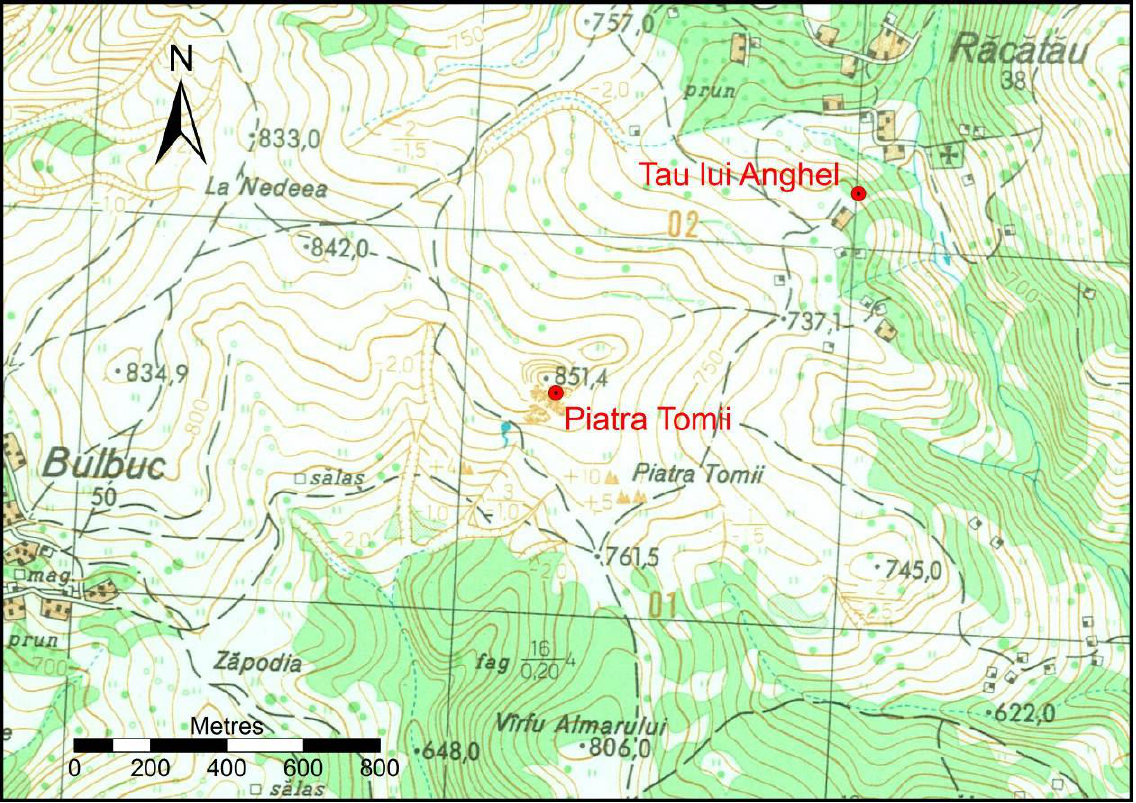
Figure 1. Topographic map of the area around Piatra Tomii. (From Romanian Topographic Map L-34-071-D-c, 2 nd Edition, 1:25,000 scale